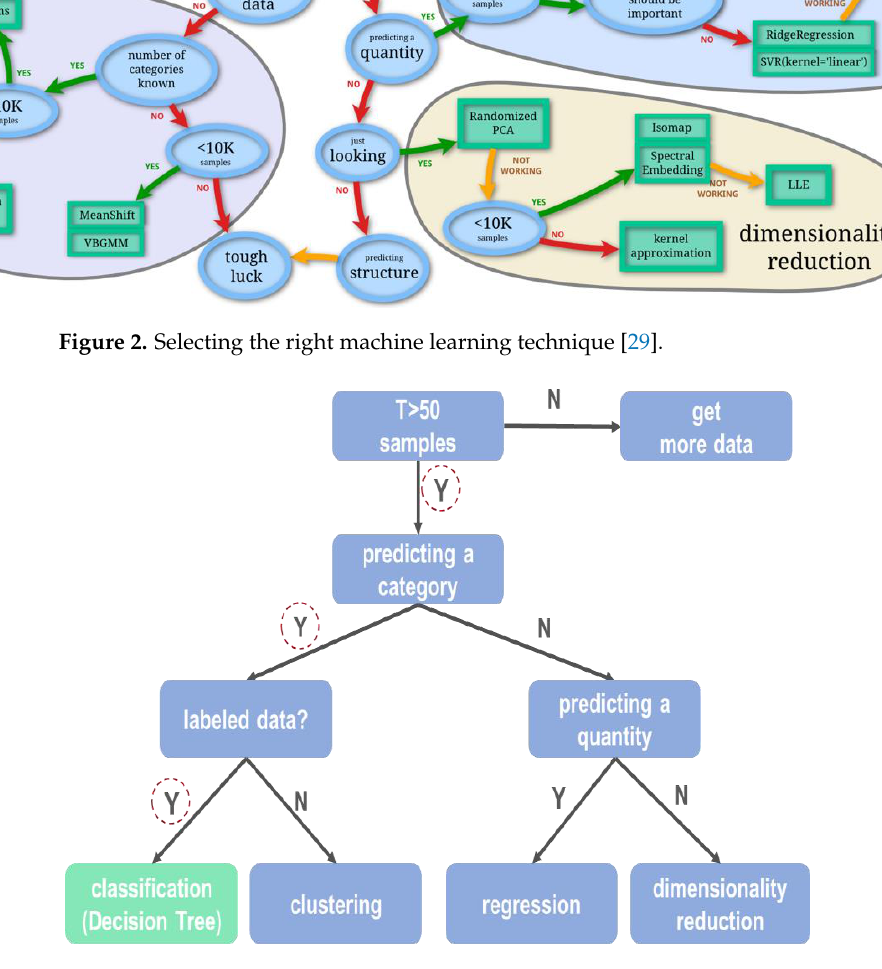
Figure 3. Flowchart for selecting machine learning techniques .